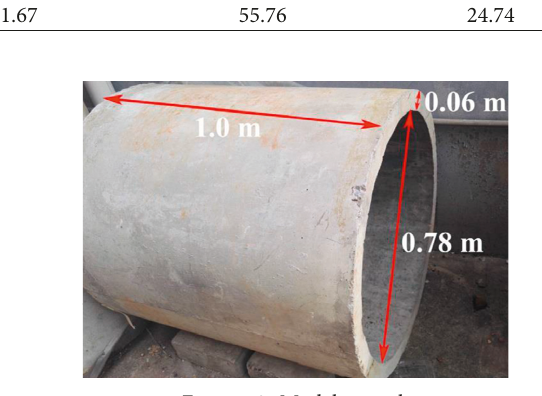
Figure 3: Model tunnel. Table 4: Model tunnels mechanical properties [27].